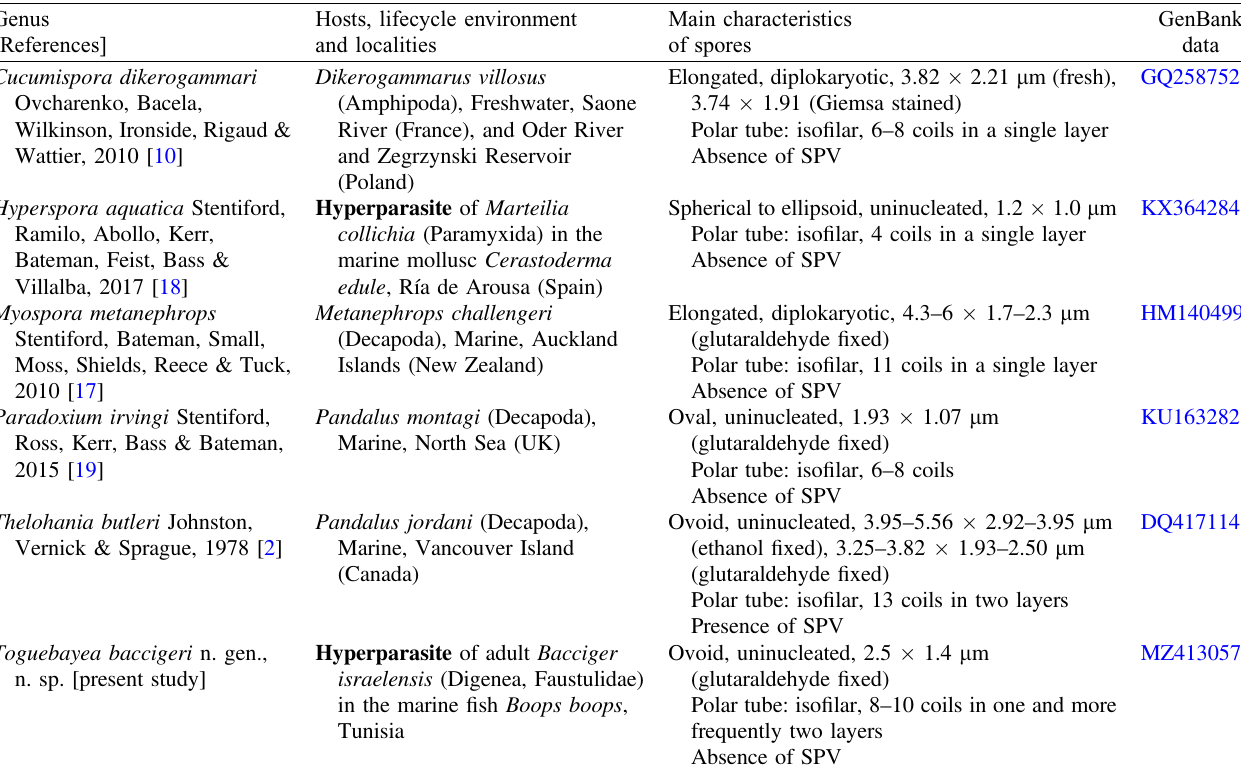
Table 1. Some characteristics of certain microsporidian species included in Clade V (Marinosporidia).